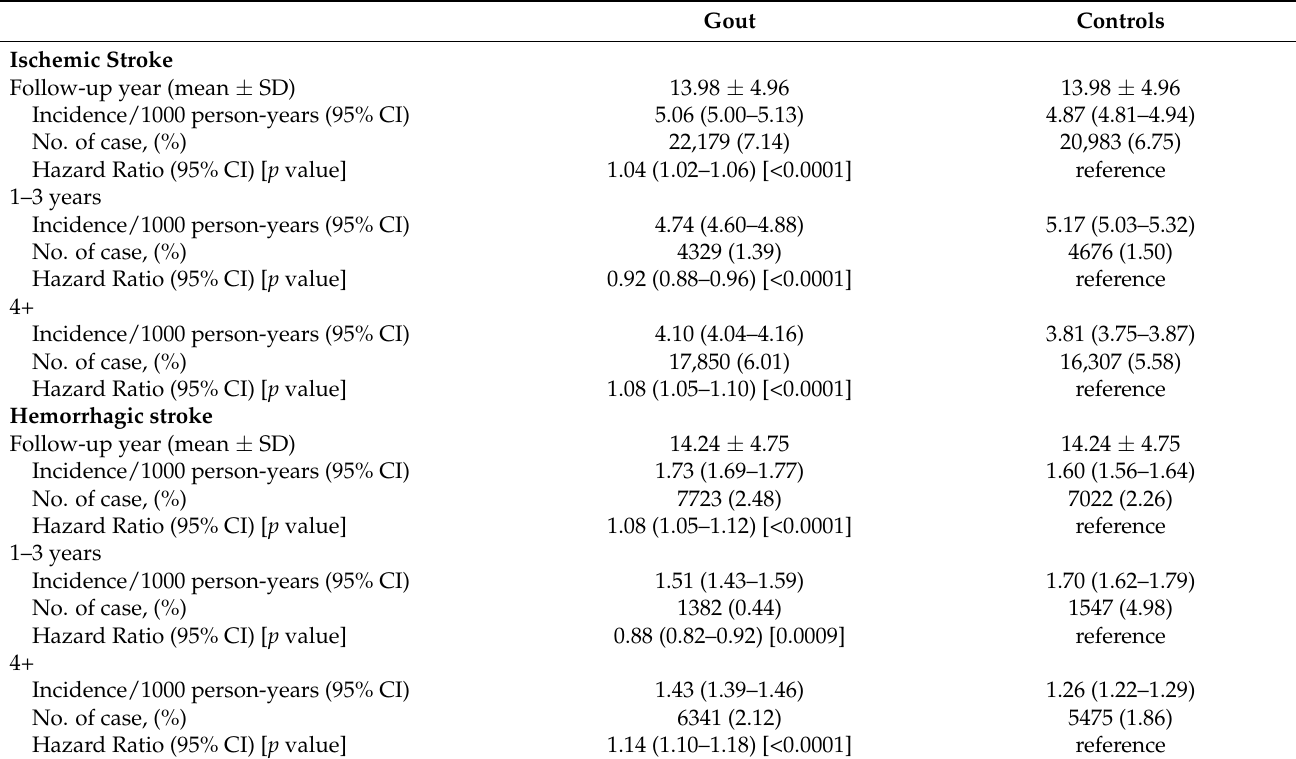
Table 2. Incidence, hazard ratios, and follow-up year for ischemic and hemorrhagic stroke among gout and non-gout cohorts in Taiwan, 2000 to 2008.